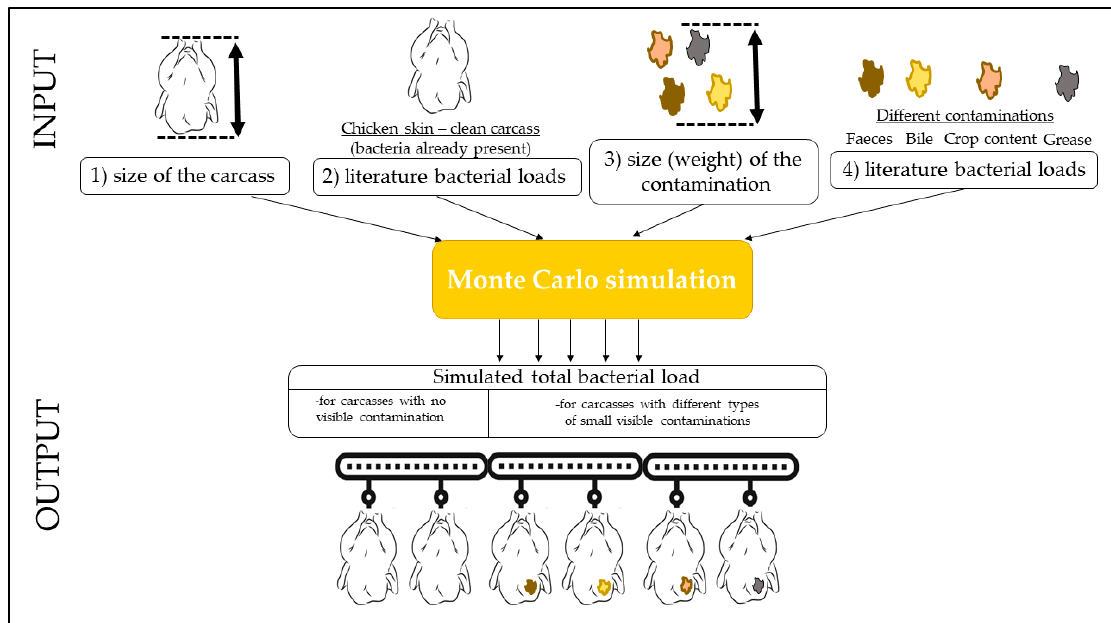
Figure 1. Data used for input in the Monte Carlo simulation.